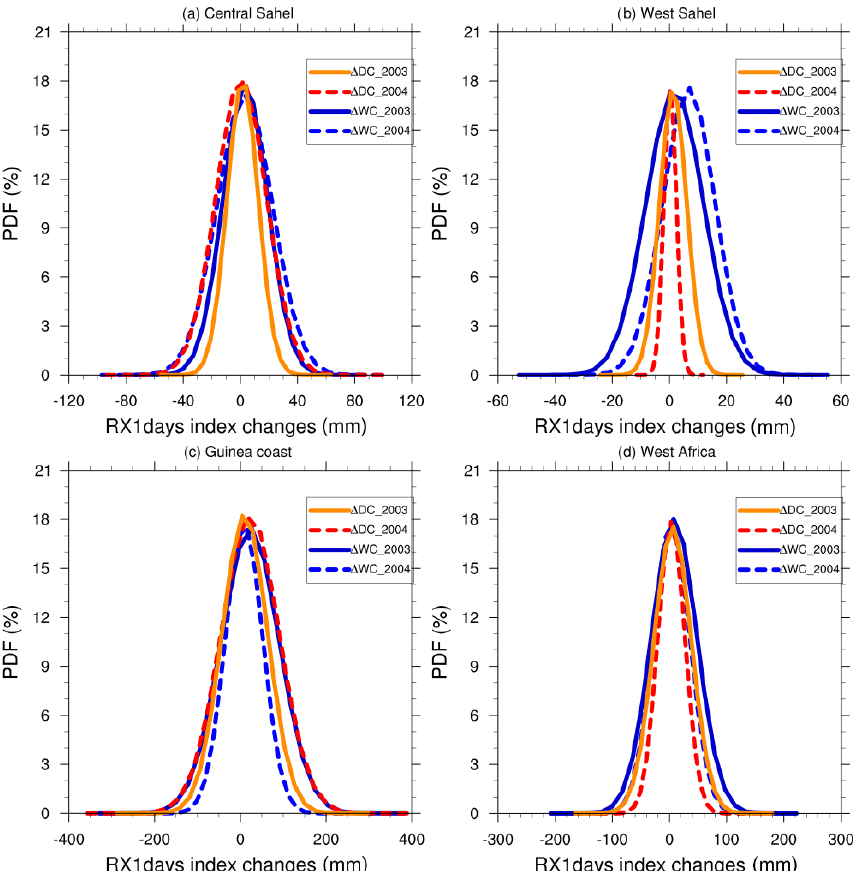
Figure 11. Same as Fig. 3 but for the RX1day index (in mm). Table 4. The pattern correlation coefficient (PCC) and the mean bias (MB, in ◦ C) of the TXx, TXn, TNn and TNx indices for the control experiments (initialized with initial soil moisture from the ERA-20C reanalysis) with respect to CPC-T2m, calculated for the Guinea coast, Central Sahel, West Sahel and entire West Africa domain for JJAS 2003 and JJAS 2004. Temperature Central Sahel West Sahel Guinea coast West Africa